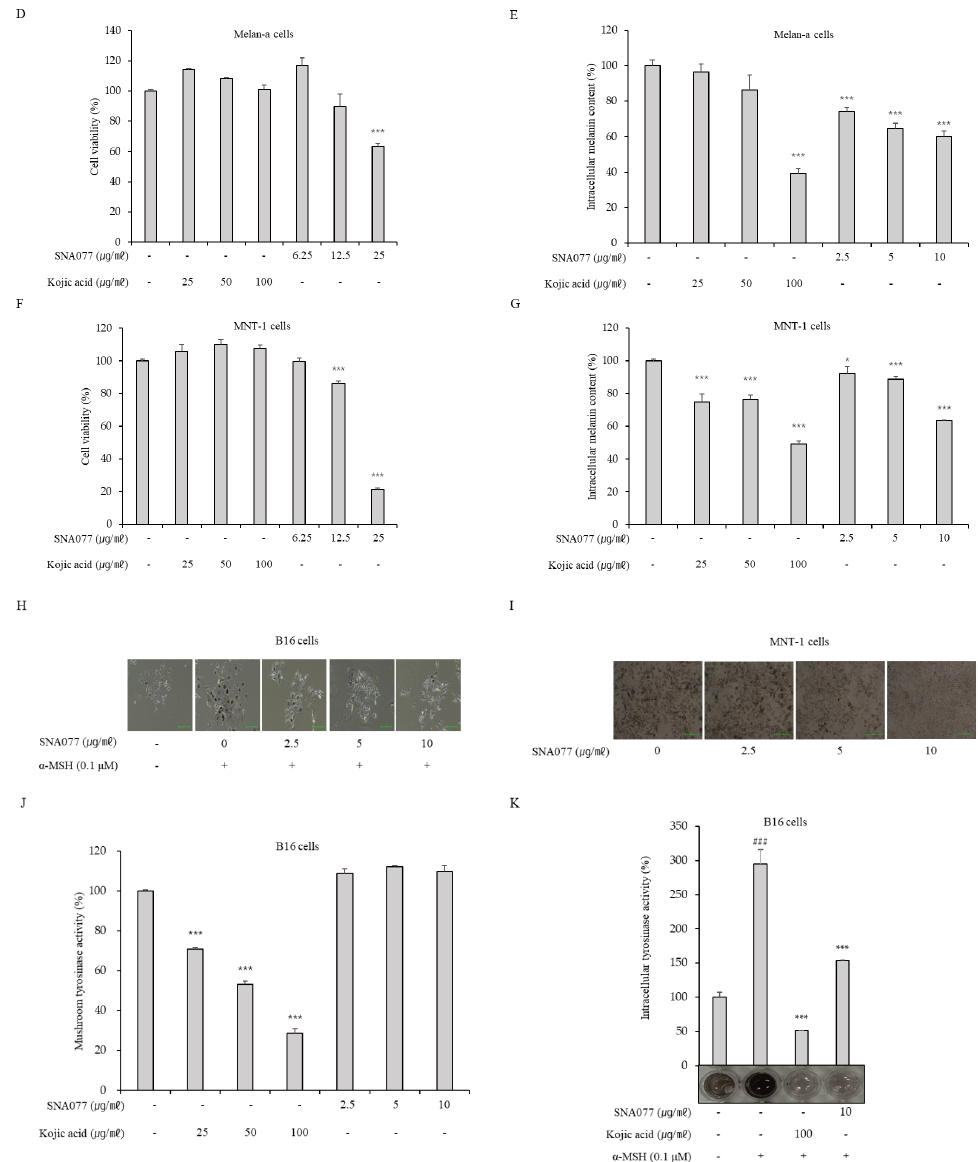
Figure 2. Anti-melanogenic efficacy of non-toxic concentrations of SNA077 in melanocytes. ( A ) Effect of SNA077 on B16 cell viability. B16 cells were treated with the indicated concentrations of SNA077 for 72 h, and cell viability was estimated using a CCK-8 assay kit. ( B , C ) Effects of a 72 h incubation with the indicated concentrations of SNA077 or kojic acid on the intracellular and extracellular melanin contents in α -MSH-stimulated B16 cells. ( B ) Extracellular melanin content was colorimetrically determined. Photographs show the color of the medium in each well following treatment with α -MSH and SNA077. ( C ) Intracellular melanin content was determined by measuring the absorbance of B16 cell lysates at 405 nm and normalizing the obtained values to the protein quantity, which was determined using a protein assay kit. Results are presented as means ± SD, expressed as a percentage relative to the control group. ( D , F ) Viability of Melan-a cells ( D ) and MNT-1 human melanoma cells ( F ) after treatment with SNA077 for 72 h. ( E , G ) Representative results show melanin contents in Melan-a cells ( E ) and MNT-1 cells ( G ) treated with SNA077 or kojic acid for 72 h. ( H , I ) Microscopy of B16 cells ( H ) and MNT-1 cells ( I ). ( J , K ) Mushroom (J ) and cellular ( K ) tyrosinase activities were spectrophotometrically measured at 475 nm, as described in Materials and Methods. Figures depict results representative of at least three replicate experiments. Results are presented as means ± SD, expressed as a percentage relative to the control group (* p < 0.05, ** p < 0.01, *** p < 0.001 vs. control group). “-” means non-treated or without any treatment and “+” means treated with the indicated compound along with α -MSH at 0.1 µ M where indicated. ### p <